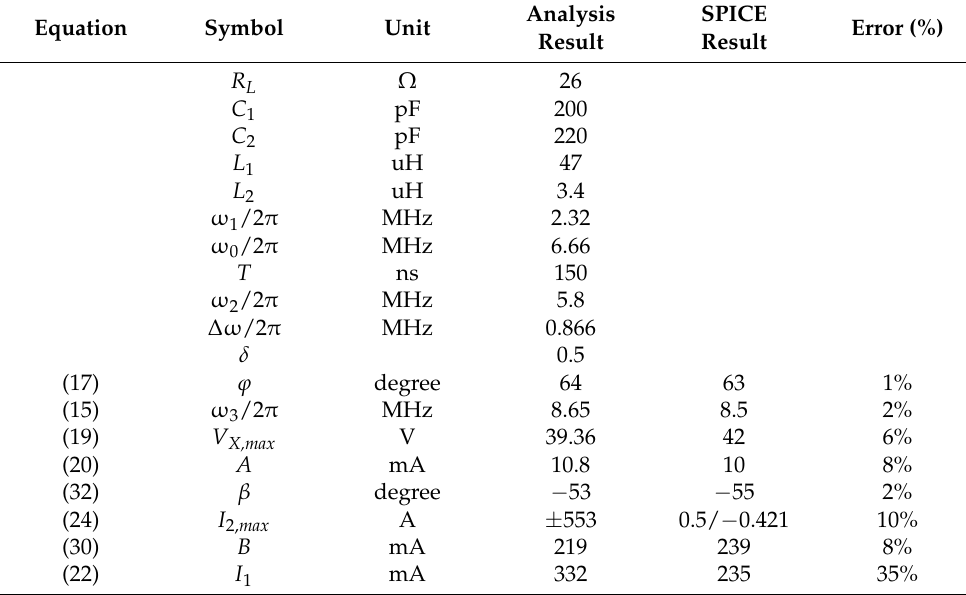
Table 2. Benchmark between equations and the SPICE result with η = 0.99. Equation Symbol Unit